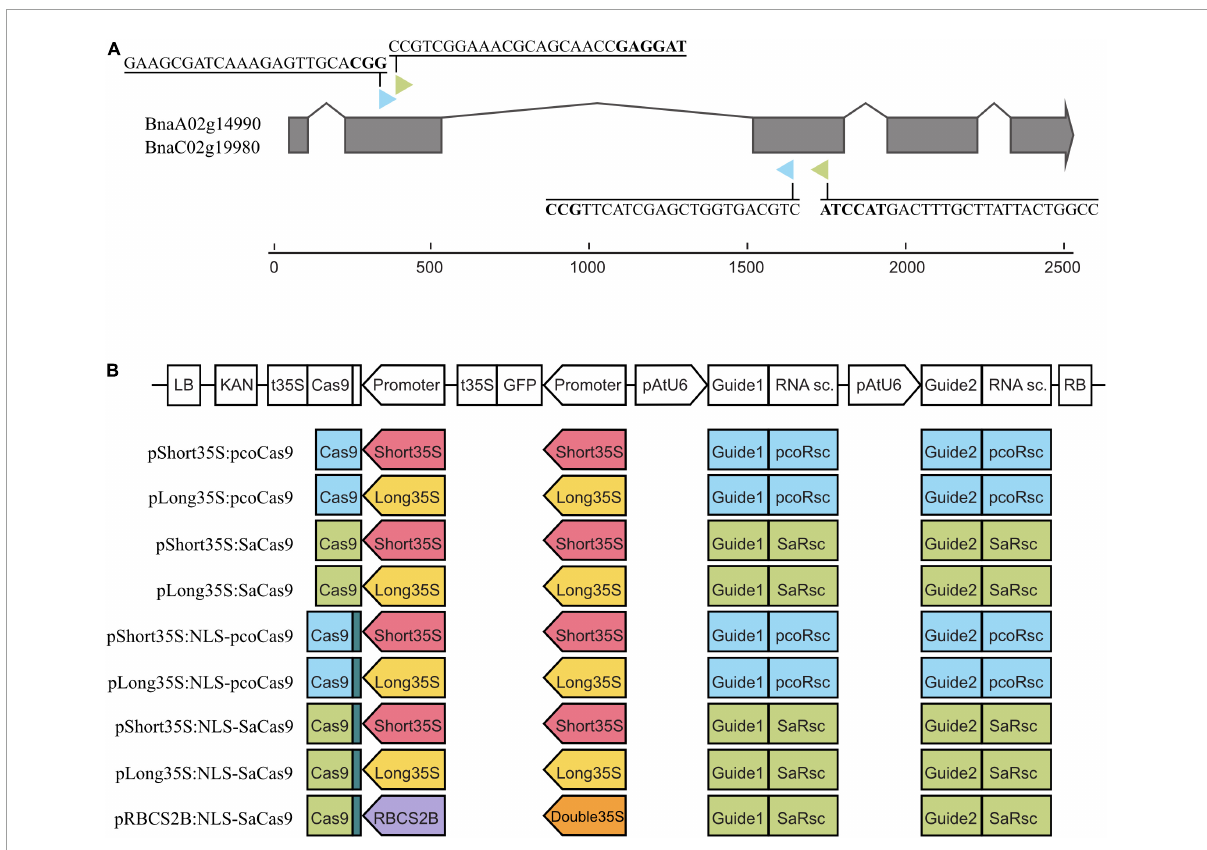
FIGURE1 Design of the CRISPR/Cas9 constructs. (A) Structure of the BnaA02g14990D ( BnaA02.TAA1 ) and BnaC02g19980D ( BnaC02.TAA1 ) genes with exons (gray boxes). The structure is identical for both genes. The colored arrowheads indicate the targeted position of the two gRNAs for pcoCas9 (blue) and SaCas9 (green). The PAM sequence is bolded. (B) Design of the nine CRISPR/Cas9 constructs. The T-DNA is composed in cis of a Kanamycin selective marker, the Cas9 cassette (promoter, Cas9 coding sequence, 35S terminator), the GFP cassette (promoter, GFP cds, 35S terminator), and the guide cassette (AtU6 promoter, gRNA, RNA scaffold). The types of promoters, Cas9, and guides are color-coded: pcoCas9 in blue, SaCas9 in green, NLS signal in dark green, short 35S promoter in red, long 35S promoter in yellow, double 35S promoter in orange, RBCS2B in purple, gRNA-RNA scaffold for pcoCas9 in blue, gRNA-RNA scaffold for SaCas9 in green.